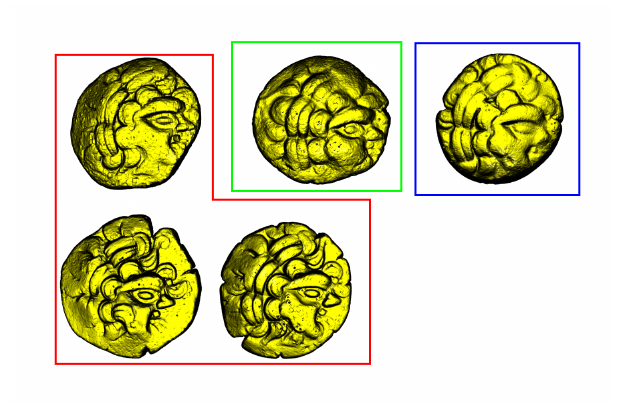
Figure 1. Example of 3D point cloud model of coins. The 3 coins framed in red have the same die. The two other coins have been struck each by a different die. You can see the similarity of the pattern for all